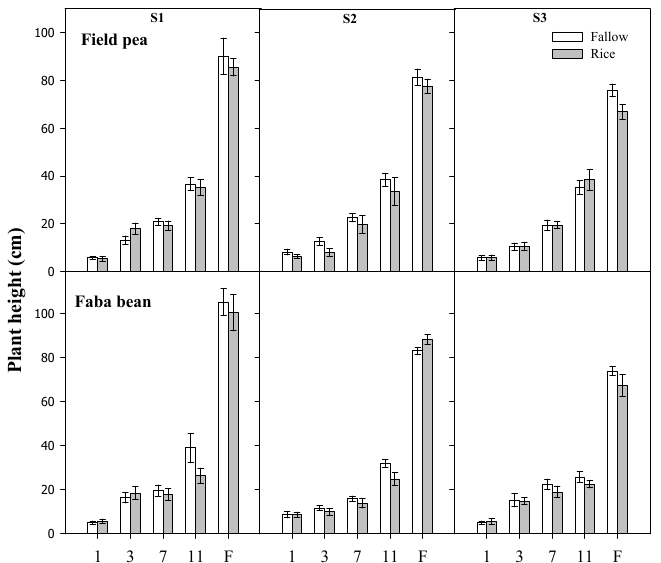
Figure 3. Plant height of field pea and faba bean grown in post-fallow and post-rice soils and at three sowing dates. Plant height was measured at 1, 3, 7 and 11 weeks after sowing and at flowering (F). The vertical error bars represent standard deviations of the means ( n = 40).